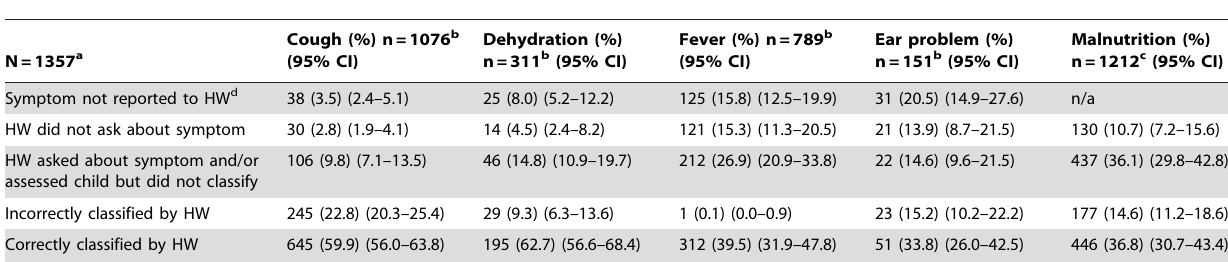
Table 3. Health worker (HW) performance in classifying children with each of the main symptoms.